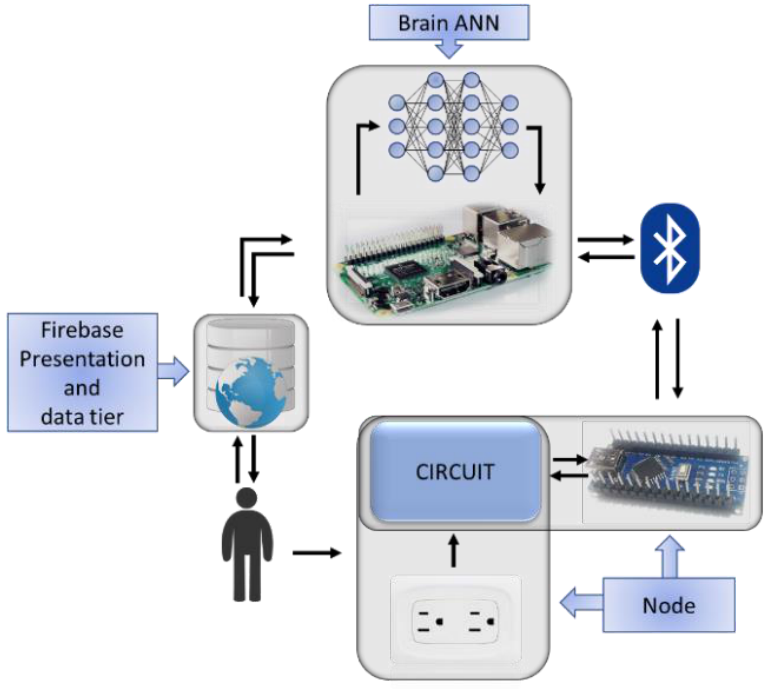
Figure 1. Process